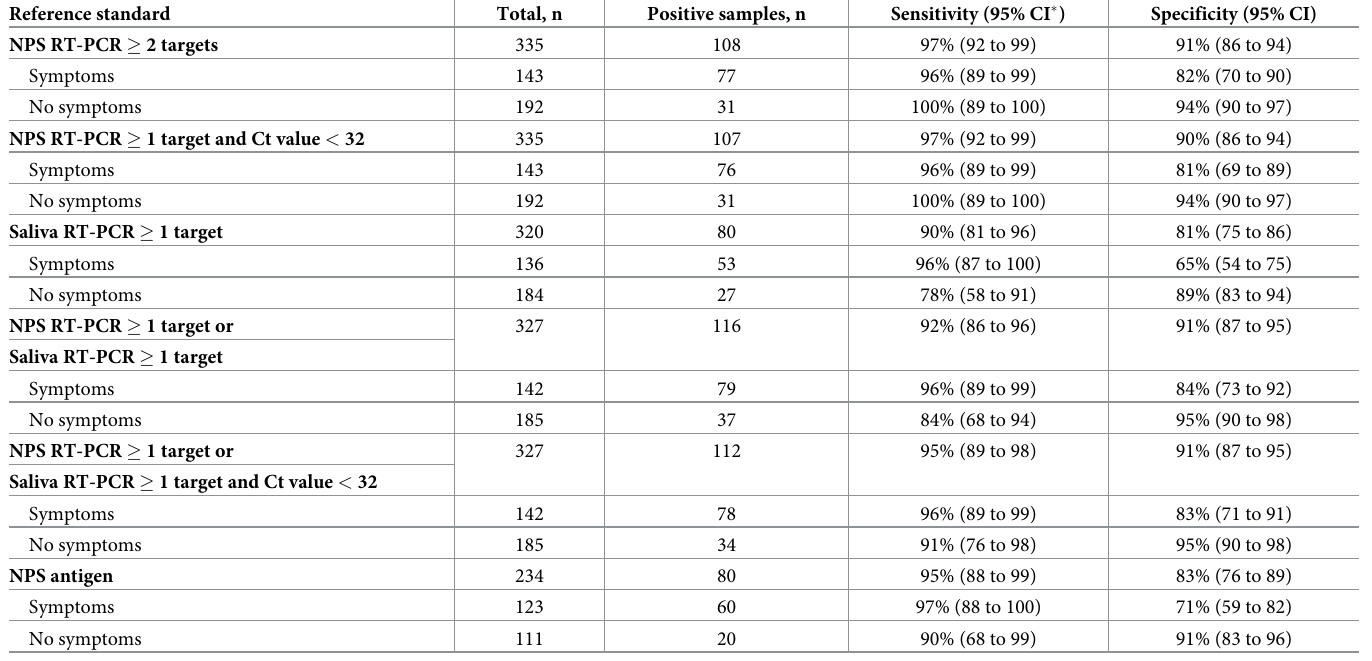
Table 3. Sensitivity analysis of the diagnostic accuracy of canine detection, as compared to several